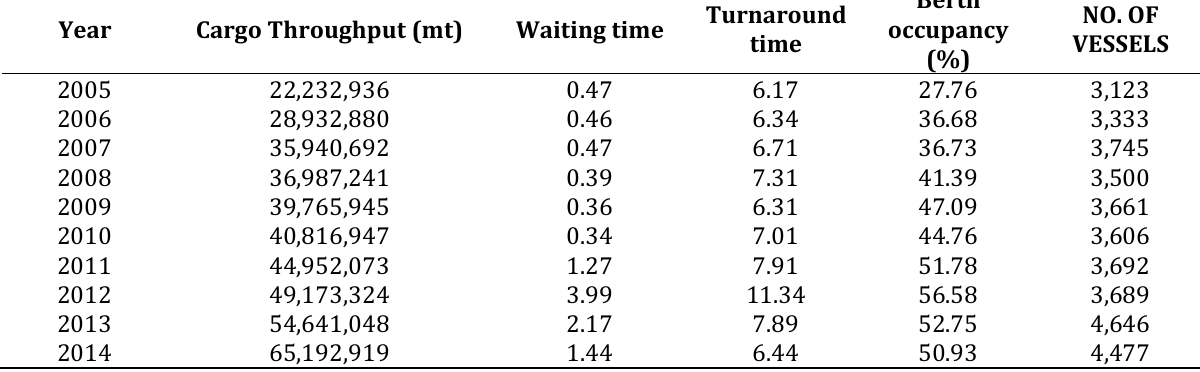
Table 4.5: Some Port Performance Indicators in Nigeria Year Cargo Throughput